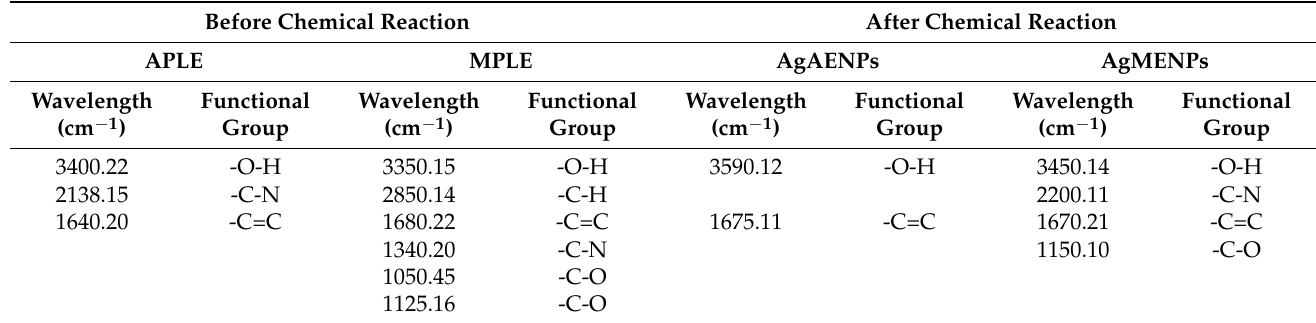
Table 2. The characteristic peaks of FTIR analysis before and after the chemical reactions.